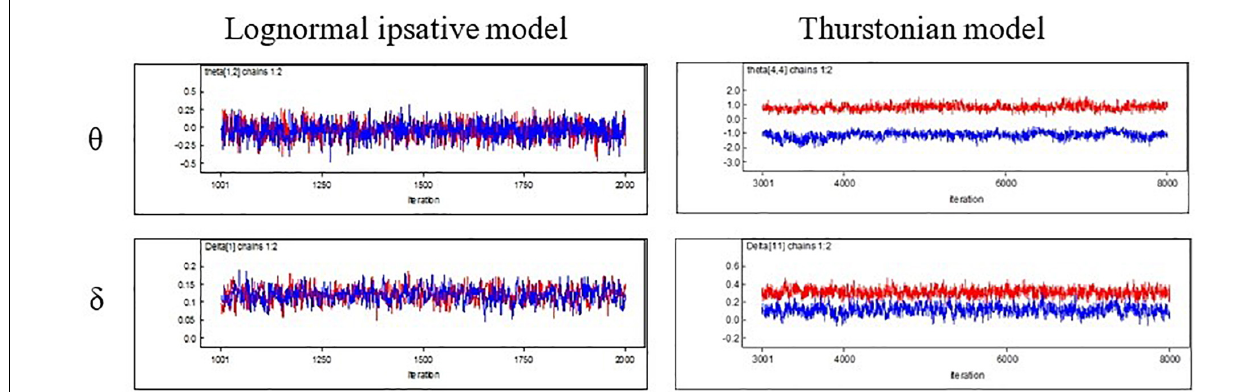
FIGURE 4 | Trace of posterior sampling for the two models in MCMC.